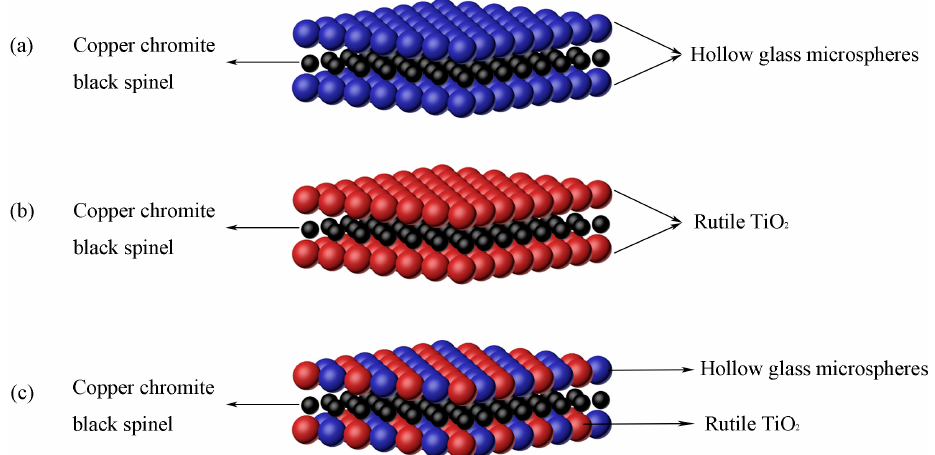
8 of 16 Figure 7. The process of setting parameters. 3. Results and Discussion 3.1. Cooling Performance 3.1.1. Effect of Functional Materials on Cooling Performance The purpose of this test was to clarify the cooling effect of different functional coat- ings. With the type of functional material as a variable, compositions 1–3 were compared under the same environmental conditions. Among them, composition 1 represents a coat-